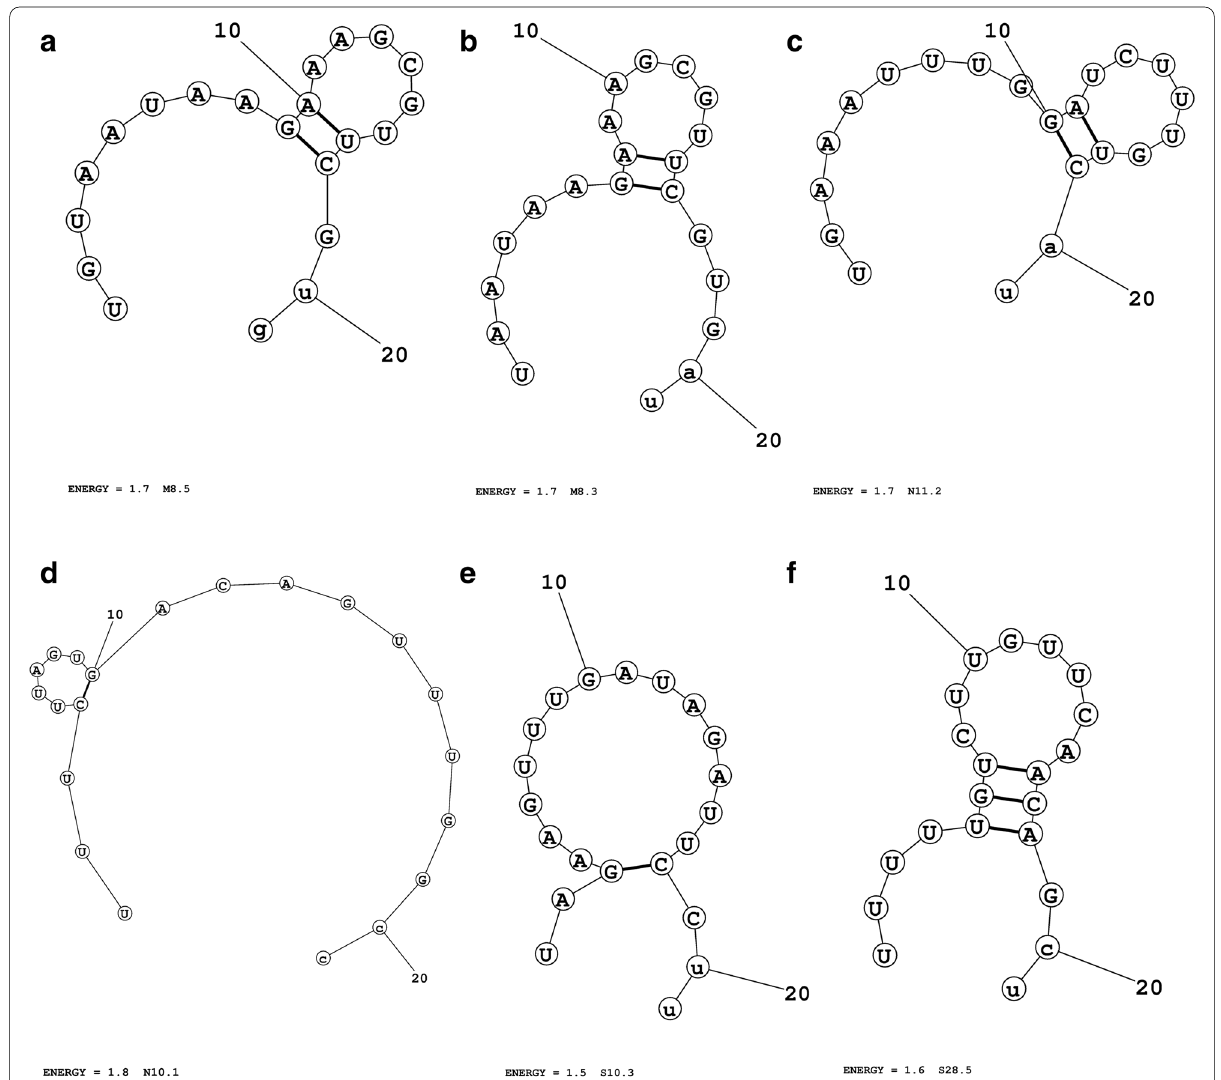
Fig. 1 a – f Secondary structure of the guide strands of siRNAs and their energy